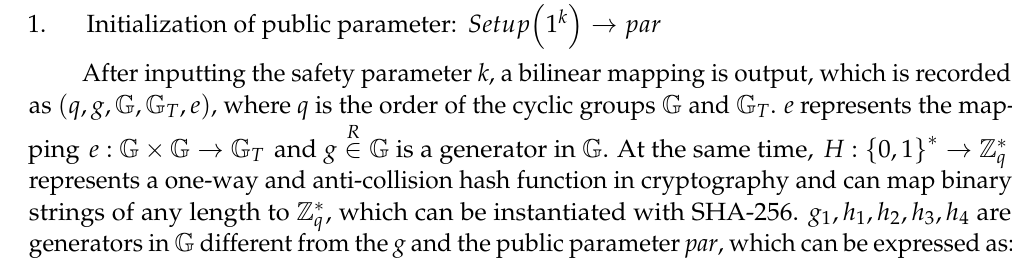
(cid:16) (cid:17) → 1 k